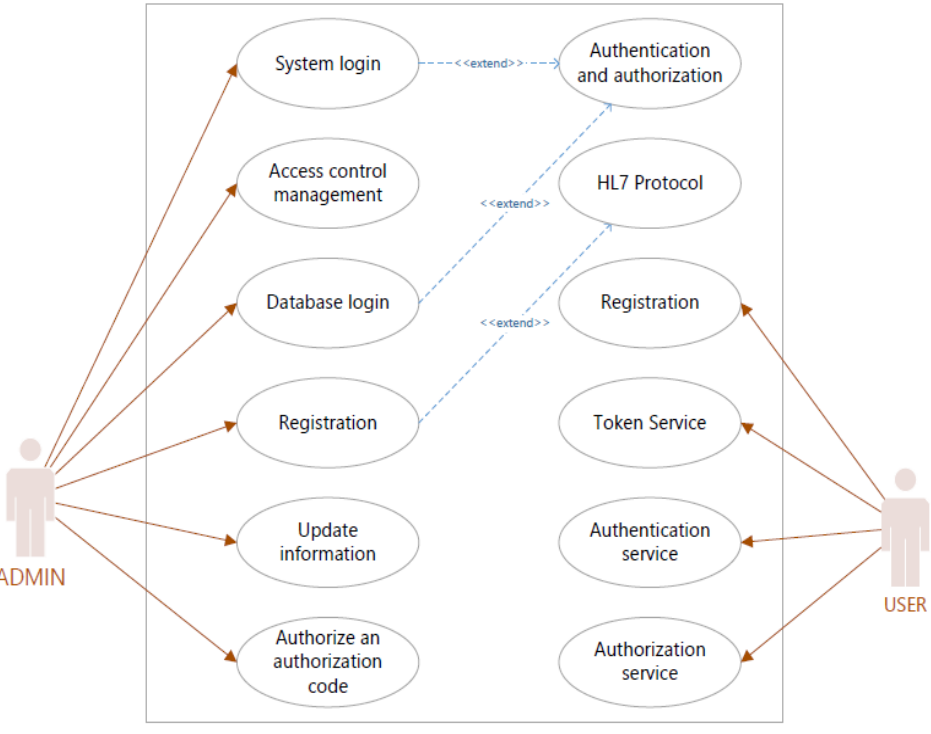
Figure 4. Authorization Server (AS) use-case for eCoach prototype system.